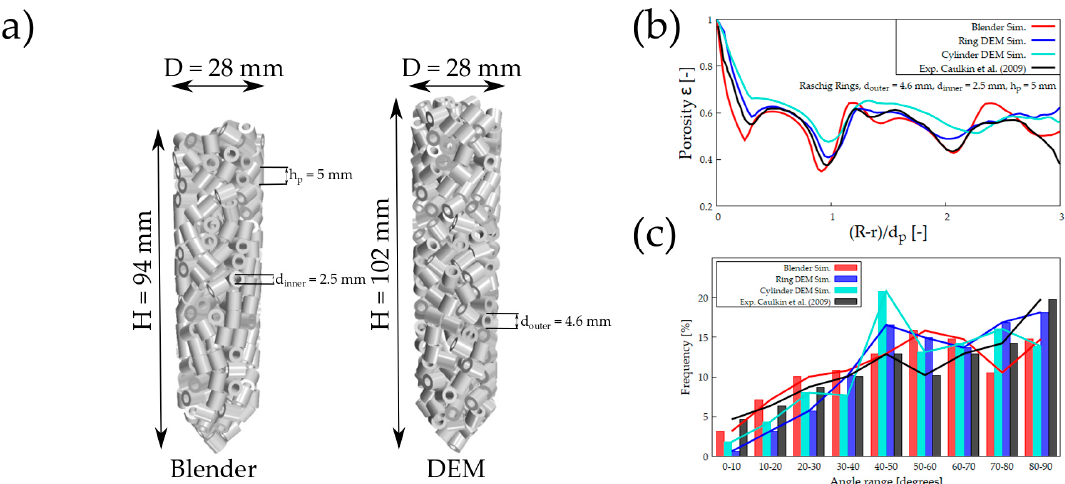
Figure 11. ( a ) Comparison between synthetic generated packing of Rachig Rings, ( b ) radial density distribution, and ( c ) particle alignment. Experiments from Caulkin et al. [15].